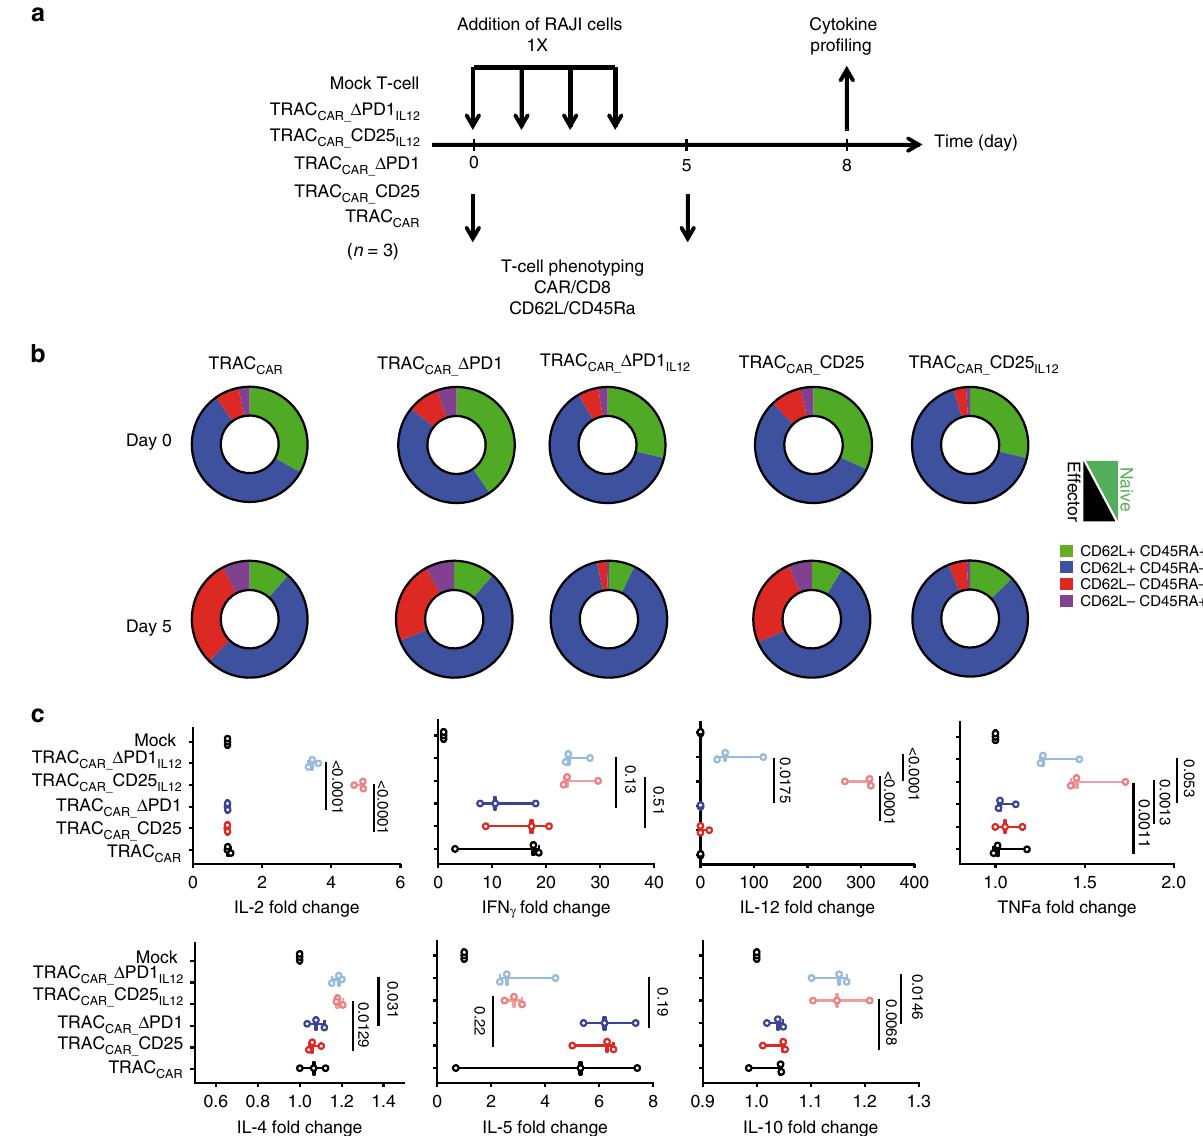
Fig. 7 Immunopro fi ling of engineered TRAC CAR T cells activated by tumor cells in vitro. a Schematic showing the experimental design to investigate the effector and memory phenotype and cytokine secretion pro fi le of activated engineered TRAC CAR T cells. 10 6 TRAC CAR T cells were mixed with a suspension of RAJI-luc tumor cells at E:T = 5:1 in a total volume of 40 mL of Xvivo-15 media supplemented with 5% AB serum and incubated in a GREX-10 device. The mixture was incubated for 24 h before adding 2 × 10 6 RAJI-Luc cells. The resulting cell mixture was incubated for 24 h and the same procedure was repeated to get a total of 4 RAJI cell challenges. The mixture was then incubated as is for 4 additional days and where spun down to recover the supernatant and determine the cytokine secretion pro fi le of TRAC CAR T cell. TRAC CAR T cells were also analyzed by fl ow cytometry to determine the frequency of CD62L and CD45RA population within CD8 + CAR + T cells (day 0 and day 5 post tumor cell-dependent activation). b Frequency of T cell subpopulation displaying CD62L + CD45RA + (naive-like), CD62L + CD45RA − (central memory), CD62L-CD45RA − (effector memory), CD62L- CD45RA + (terminal effector) labeling and obtained at day 0 and day 5 post tumor cell-dependent activation for different engineered T cells. A linear mixed model, using lmer from the lme4 R package was used for statistical analysis. p-values are documented in Supplementary Table 1. c Cytokine pro fi ling assay results obtained from supernatant of engineered T cell/RAJI cells cocultured for 5 days. The data shown in b and c represent the average of three experiments performed with cells engineered from three different donors. The mean of cytokine concentration fold change and the whiskers representing the maximum and minimum data points are illustrated in c . Two-way ANOVA was used in panel c for statistical analysis (p-value are indicated on the fi gures). Source data are provided as a Source Data fi